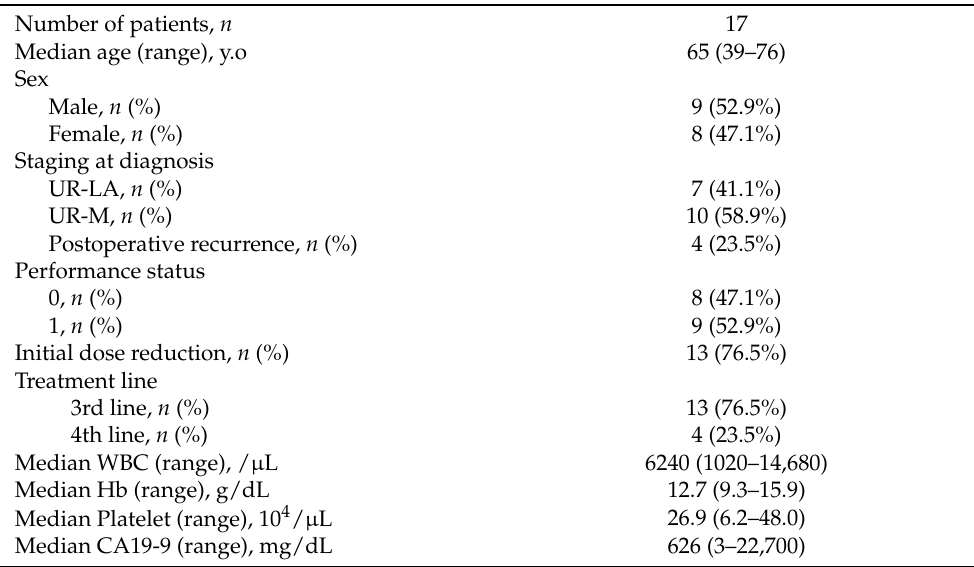
Table 1. Patient characteristics in the present